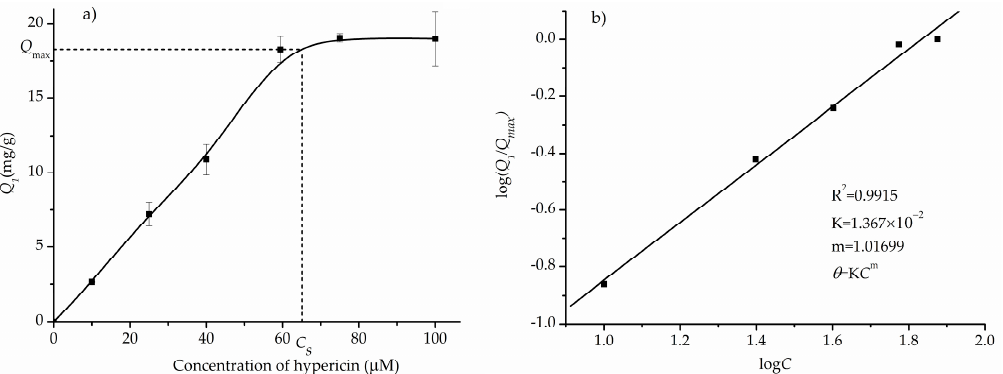
Figure 7. ( a ) The adsorption isotherm of Fe 3 O 4 @PDA/Hyp NSs towards hypericin; ( b ) The fitting plot of the adsorption isotherm of Fe 3 O 4 @PDA/Hyp NSs towards hypericin by Langmuir isotherm.